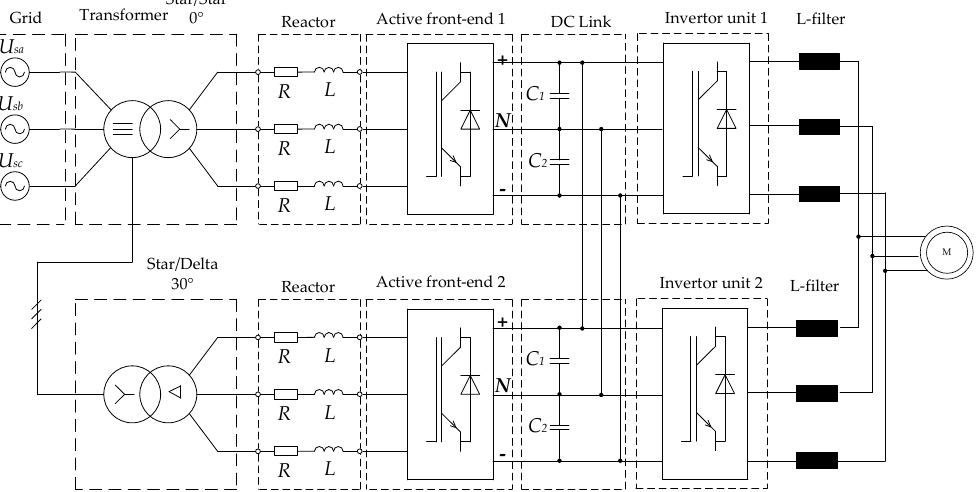
Figure 3. The 12-pulse circuits based on a net-side phase-shift transformer with series-connected primary windings.